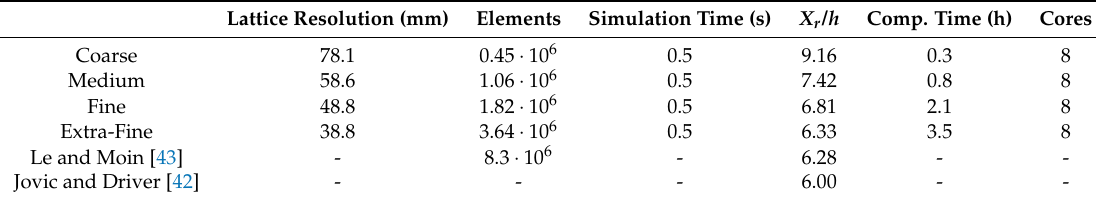
Table 1. Grid independence with Re h =